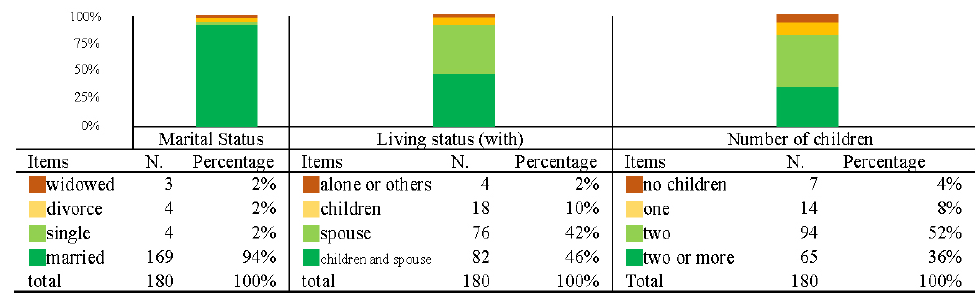
Figure 6. Descriptive statistical results of participants’ marital status, living status, and the number of children.